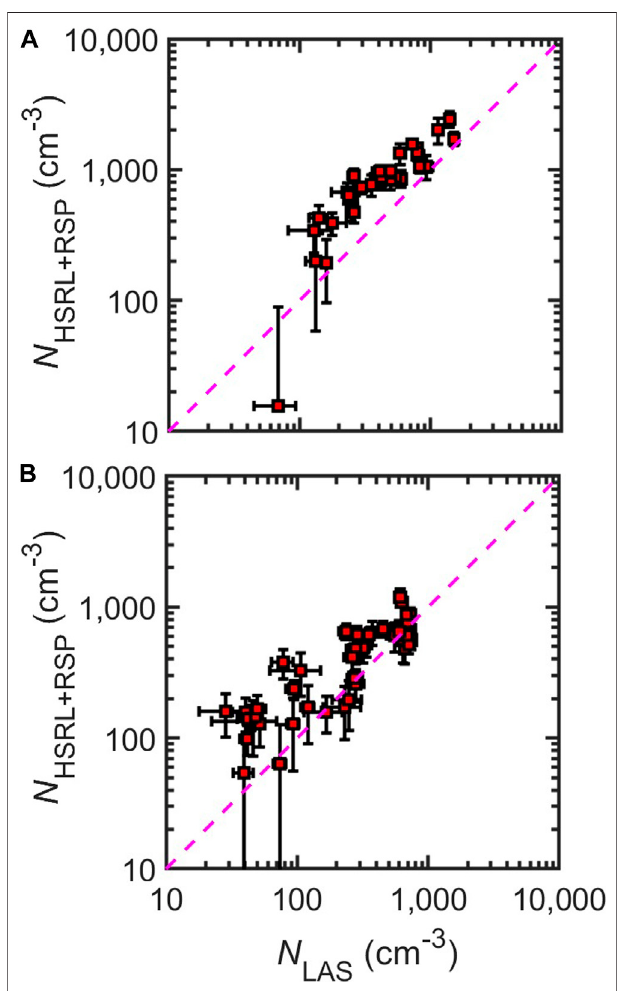
FIGURE 5 | Log-log plots of N HSRL+RSP versus N LAS from (A) optimal in situ pro fi lethatoccurredbetween15:46:25and15:58:12(UTC)on26August 2020 and (B) optimal in situ pro fi le that occurred between 17:35:18 and 17: 54:11 (UTC) on 28 August 2020. The goodness of fi t statistics that correspond to panel (A) are r = 0.92, median relative bias = 64%, NMAD = 29%, NRMSD = 33%, and n p = 34. The goodness of fi t statistics for panel (B) are r = 0.81, median relative bias = 42%, NMAD = 21%, NRMSD = 28%, and n p =